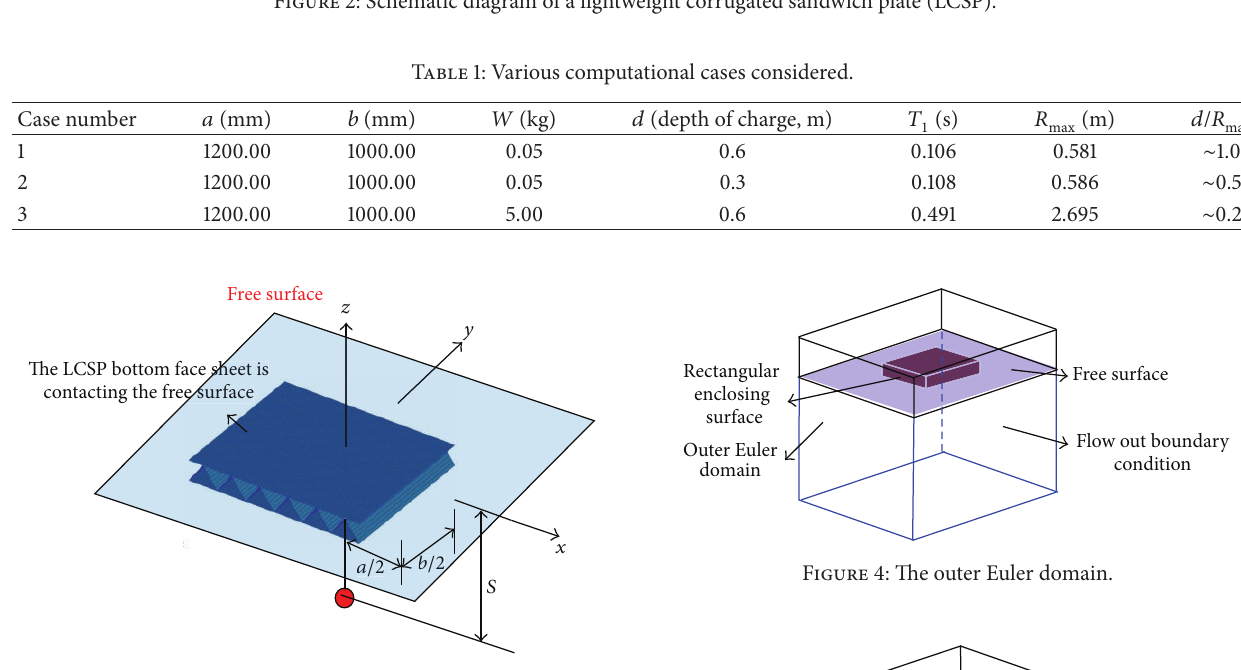
Figure 3: Lagrange FE model of LCSP and location of charge.